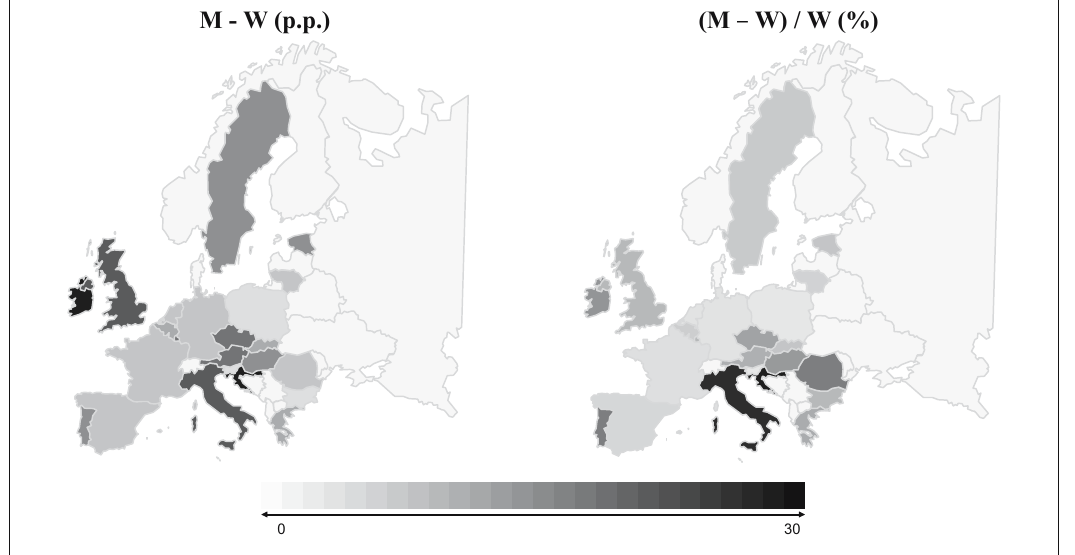
Figure 8: Digital gender gap in the ICT - PURCHASE indicator in the EU - 28, 2019. Nota: A Chipre le corresponde el mismo color que a Finlandia. Note: Cyprus has the same color than Finland. Source: Own elaboration based on the Digital Economy & Society Database ( Eurostat ) and using Clearly and Simply ( https://www.clearlyandsimply.com/clearly_and_simply/2009/06/choropleth - maps - with - excel.html )